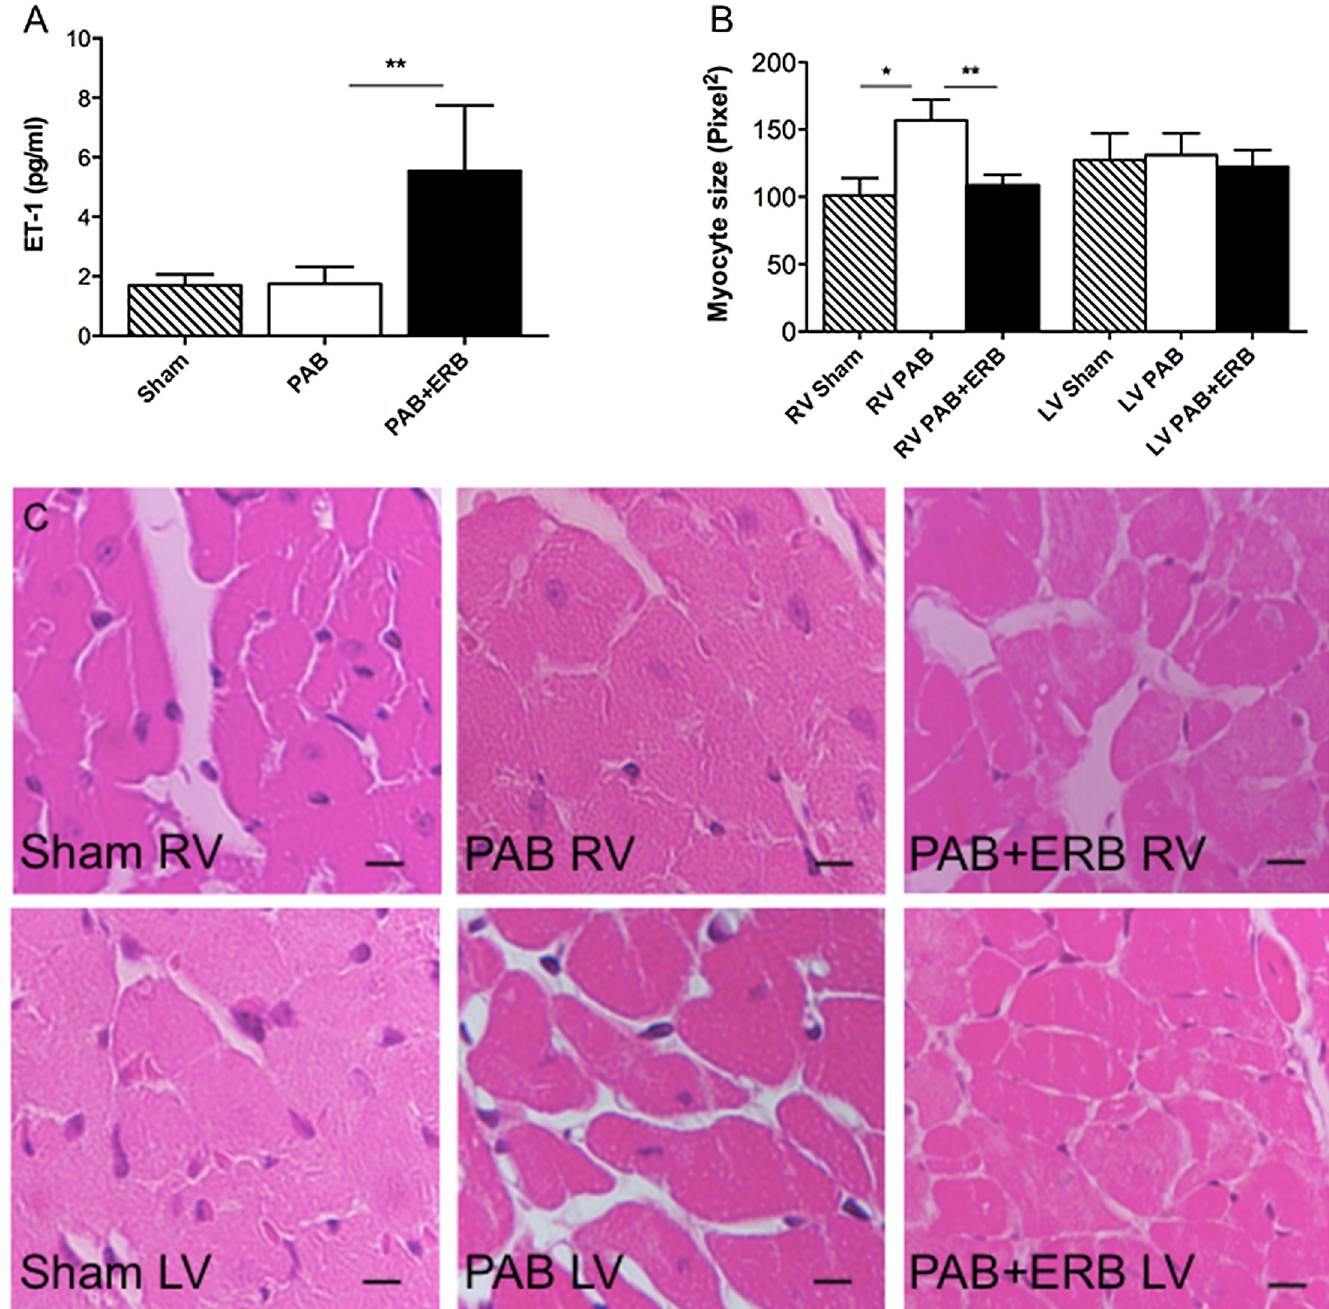
Fig 1. Circulating ET-1, and macitentan levels and ventricular morphology. A) Plasma concentrations of endothelin-1 (ET-1) were unchanged in Sham (n = 3) compared to PAB (n = 11), but increased significantly with addition of macitentan (PAB+ERB n = 7) ** p (cid:1) 0.001. B) Bar graph showing a significant increase in myocyte size in the PAB group vs. sham for the RV ( * p (cid:1) 0.0001), measured in transverse cut myocytes (n = 4 Sham group, n = 7 for the PAB group, and n = 13 for the PAB+ERB group). Addition of endothelin receptor blocker (PAB+ERB) resulted in a significantly decreased cardiomyocyte size vs. PAB in the RV, ** p (cid:1) 0.0001. For the LV there were no change in myocyte size. C) Hematoxylin-eosin staining, magnification × 40 the black lines is a micron bar indicating 20 μ m. RV: right ventricle, LV: left ventricle, PAB: pulmonary artery banding, and ERB: endothelin receptor blocker.